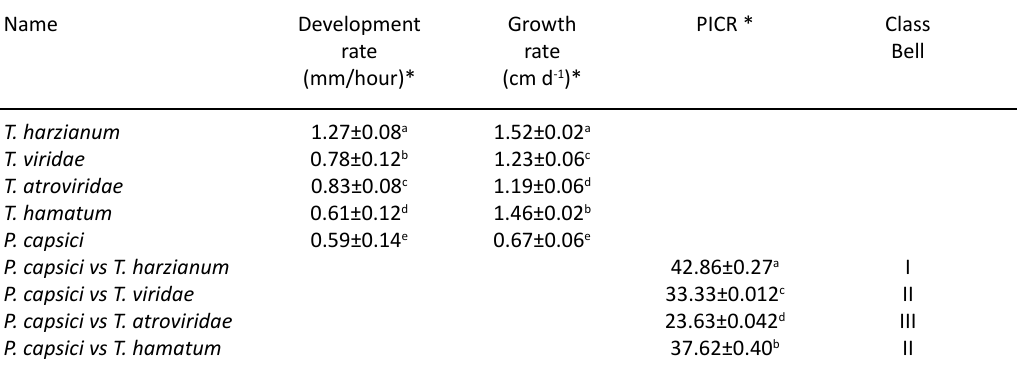
Table 3. Development rate, growth speed, percentage of radial growth inhibition and antagonism classification on Bell Scale 18